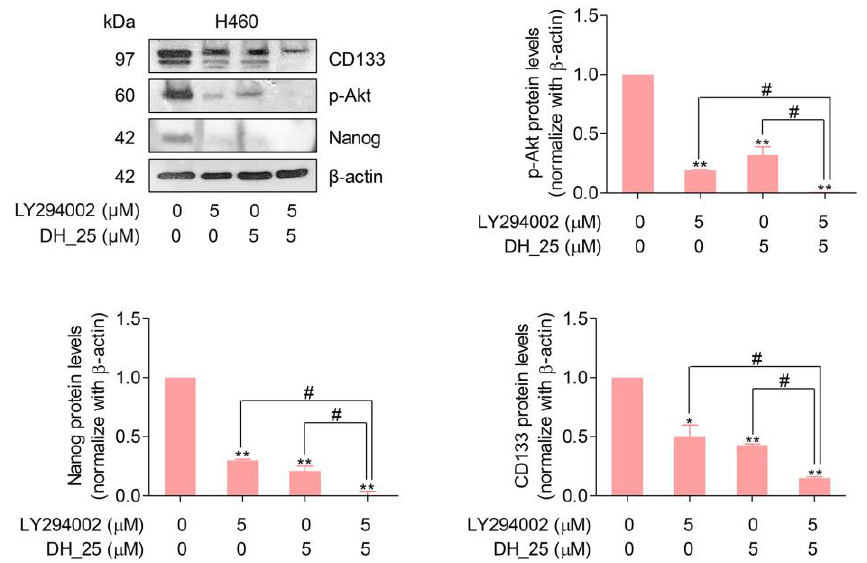
Figure 8. DH-25 regulates Nanog and CD133 through p-Akt inhibition in NSCLC cells (H460). NSCLC cells (H460) were seeded and treated with 0–10 µ M of DH_25 for 24 h. In the conditions that LY294002 (5 µ M) was used, it was added to pretreat the cells for 0.5 h before treatment with DH_25. Western blot analysis was performed to detect the protein levels of p-Akt, Nanog, and CD133. The blots were reprobed with β -actin to confirm an equal loading. Densitometry was used to calculate protein expression levels, and results were presented as fold changes relative to the uncleaved form, or β -actin. Uncropped blotting bands are presented in Figure S8. Data are presented as the mean ± SD ( n = 3) (* 0.01 ≤ p < 0.05, ** p < 0.01, compared with the untreated control, and # 0.01 ≤ p <0.05, compared with the treatment alone).